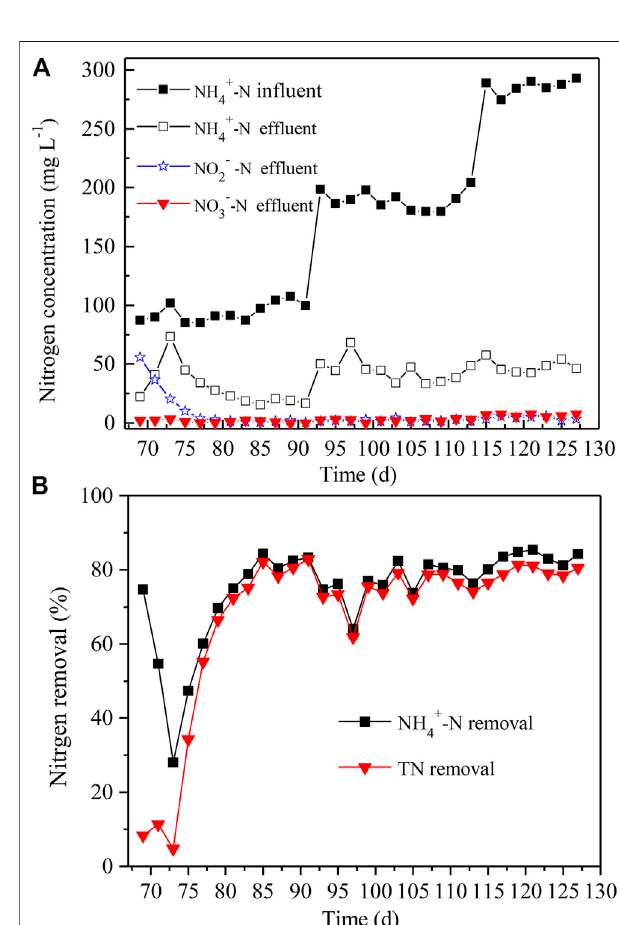
FIGURE 6 | The ef fl uent (A) and nitrogen removal (B) in microalgae- intensi fi ed PN/A reactor with distinct NH 4+ -N and NO 2 − -N concentrations of in fl uent. The NH 4+ -N and NO 2 − -N concentrations varied from 100, to 200, to 300 mg L − 1 . TN removal denotes the removal rates of total nitrogen.